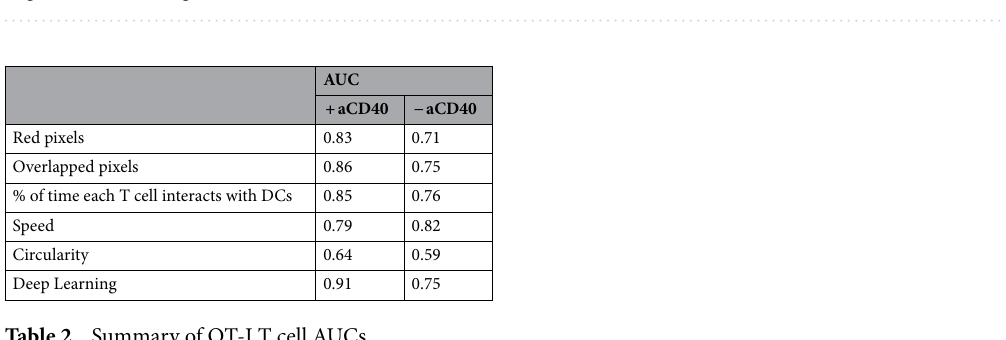
Figure 2. Using traditional image analysis methods to classify cognate vs. non-cognate T cell-DC interactions, with or without aCD40. ( a ) IL-2 secretion by cognate and non-cognate T cells incubated with and without aCD40 (mean ± standard deviation). ( b )–( e ) Distributions of ( b ) overlapped pixels ( c ) red pixels ( d ) speed and ( e ) circularity for cognate and non-cognate OT-I T cells incubated with or without aCD40, averaged over all of the frames in the video. ( f ) ROC curve quantifying the ability of the different metrics to discriminate between cognate and non-cognate T cells.